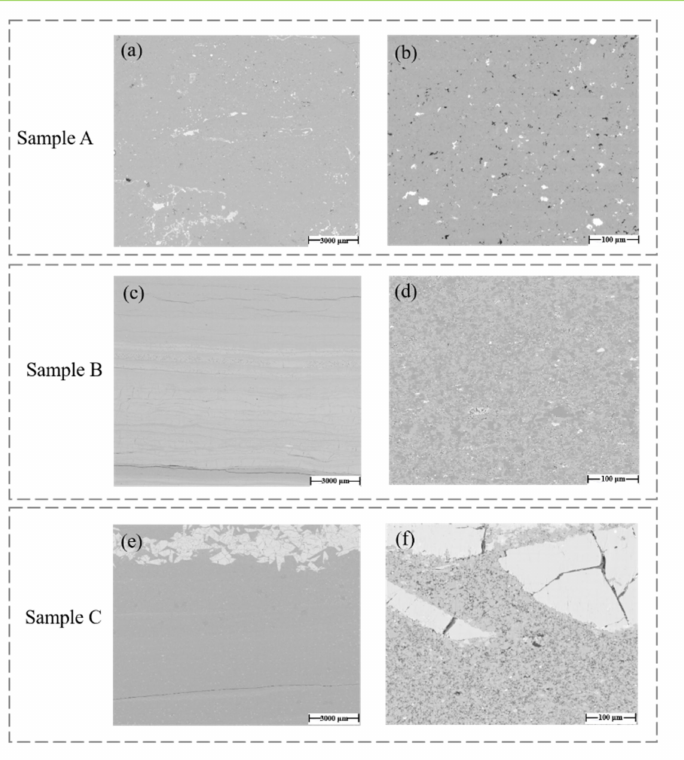
Figure 3. MAPS crude ( a , c , e ) and fine ( b , d , f ) scanning test results of sample A, sample B, and sample